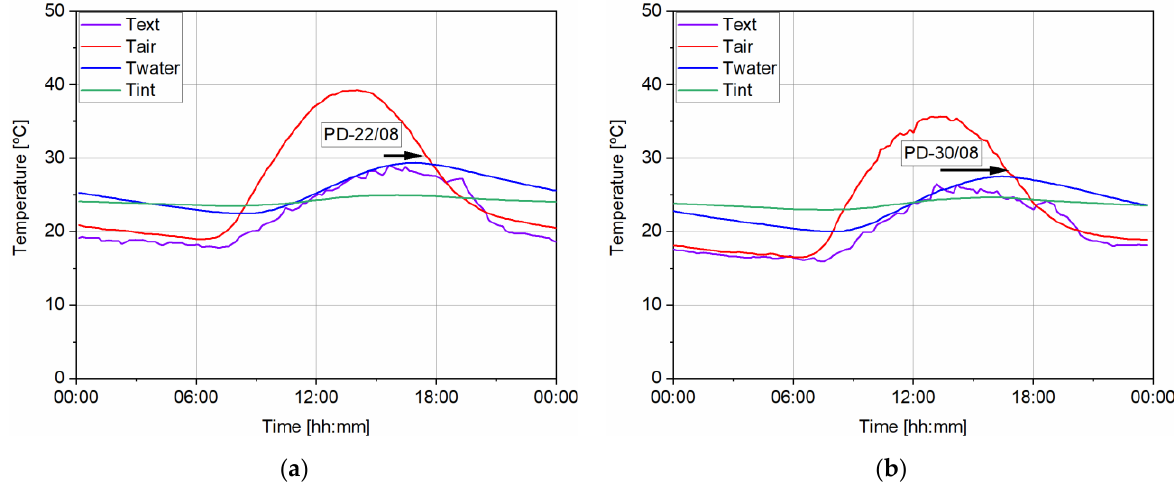
Figure 11. BIPV-WS layer temperature evolution: ( a ) August 22nd, non-ventilated air cavity; ( b ) August 30th, ventilated air cavity.